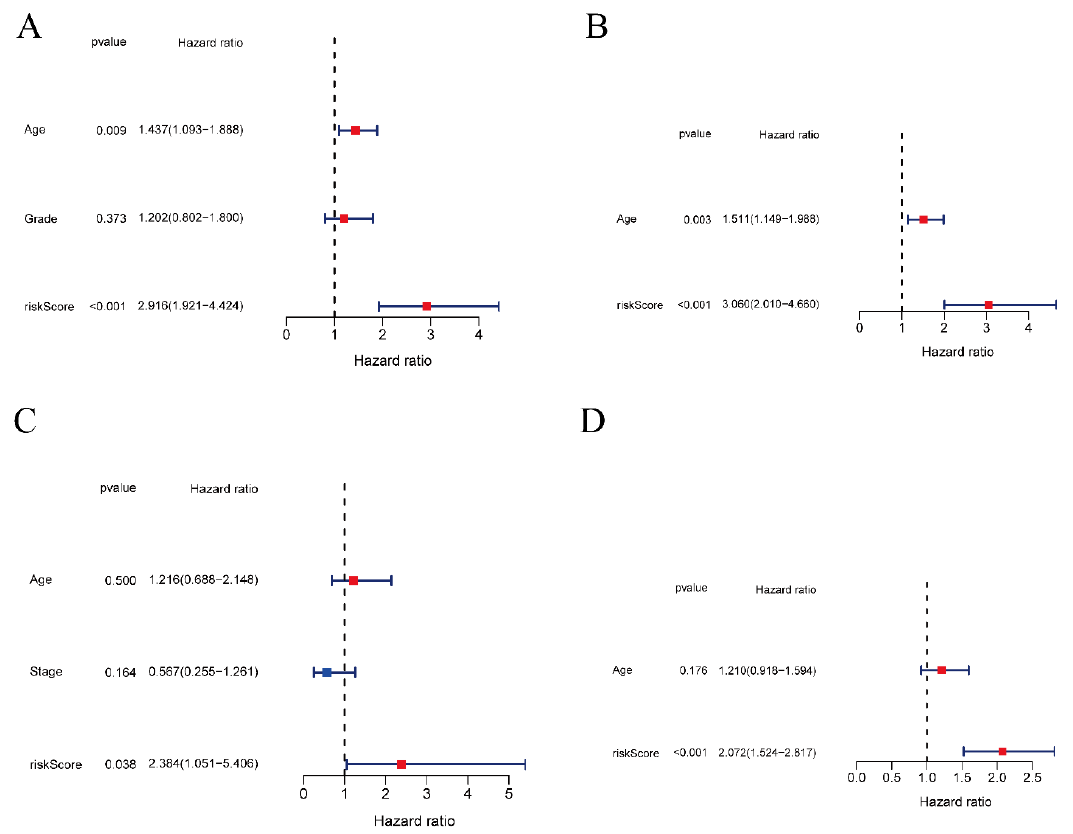
Figure 6. Univariate and multivariate independent prognostic analyses. ( A ) Univariate independent prognostic analysis in the TCGA cohort. ( B ) Multivariate independent prognostic analysis in the TCGA cohort. ( C ) Univariate independent prognostic analysis in the ICGC cohort. ( D ) Univariate independent prognostic analysis in the GEO